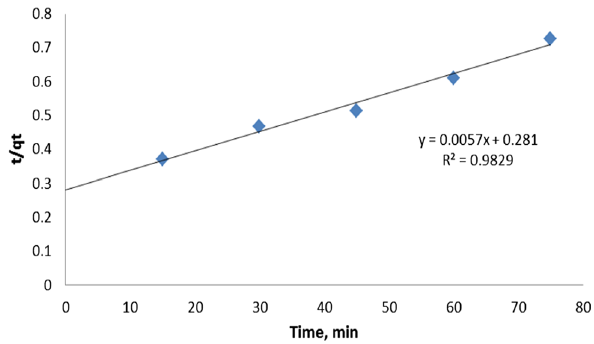
Fig. 9 Pseudo-second-order kinetic for biosorption Cd(II) pH 5